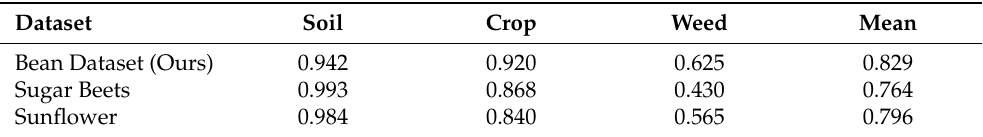
Table 5. Comparison between the Bean dataset, Sunflower dataset, and Sugar Beet dataset using the BiSeNet network with ResNet 18 as the